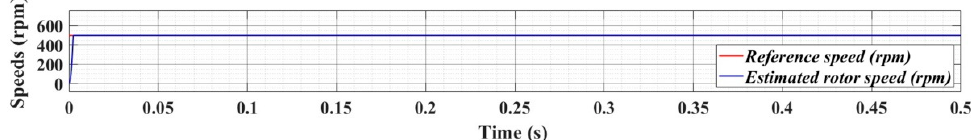
Figure 10. Block diagram for the ESO-type observer.